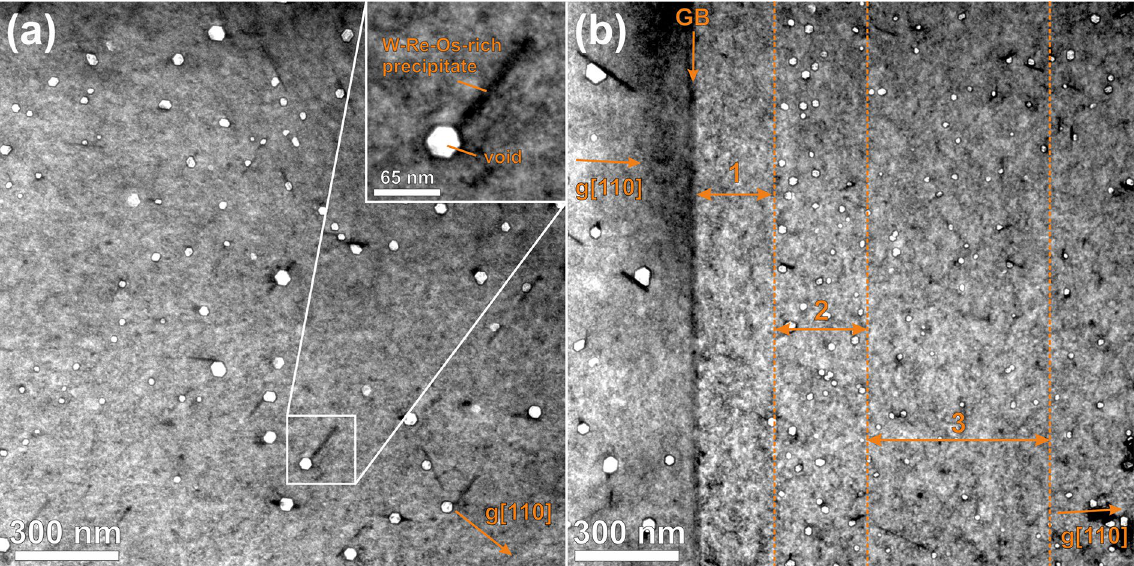
Figure 1. Bright-field TEM images acquired from neutron-irradiated W. ( a ) A representative area of a grain interior with voids (bright spots) and Re–Os-rich precipitates (dark strips). The inset shows a magnified view of a individual void attached to a W–Re–Os-rich precipitate. ( b ) A representative GB region. The numbered areas are (1) the void denuded zone, (2) void-peak zone and (3) the second denuded